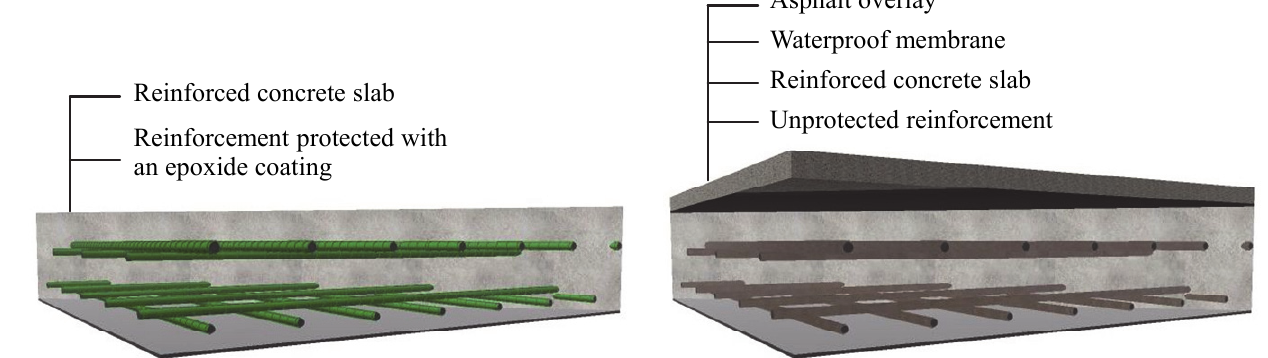
Figure 1: The RC bridge deck scheme with epoxide protection of reinforcement typical for the North East part of the USA (left) and waterproof insulation typical for Central Europe